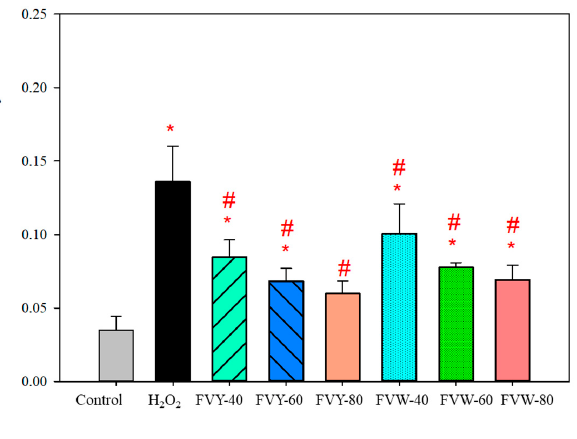
Figure 8. ( a ) Radical scavenging effect of FVYs and FVWs on L929 cells against H 2 O 2 -induced ROS generation by fluorescence microscope. ( b ) All data were expressed as a mean ± standard deviations. ( n = 3). *p < 0.05 vs. H 2 O 2 -induced group, while #p < 0.05 vs. control group.